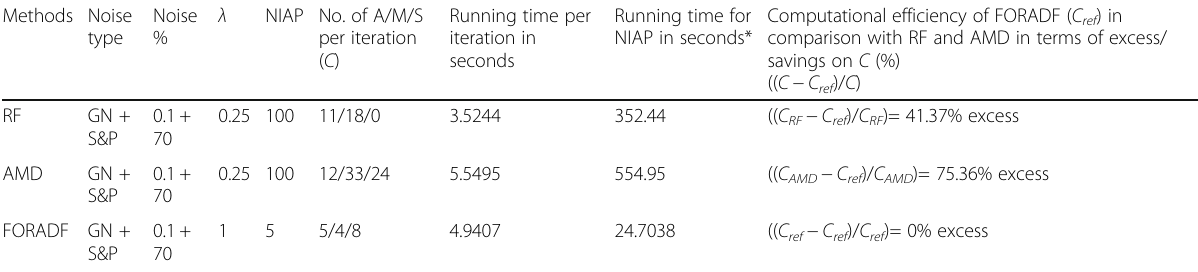
Table 5 Hardware complexity in DSP context